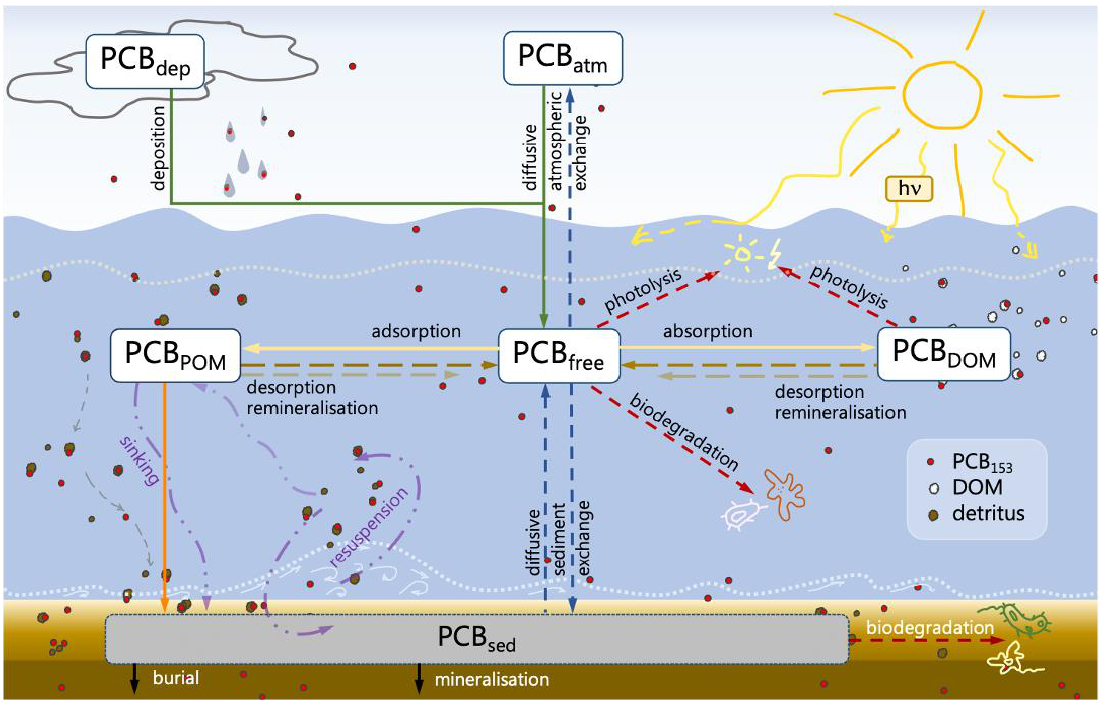
Figure 3. Main processes of PCB 153 transformation in current model. Arrows: green — input; yellow — phase transformation; purple — physical processes; red — removing of pollutants from the system.